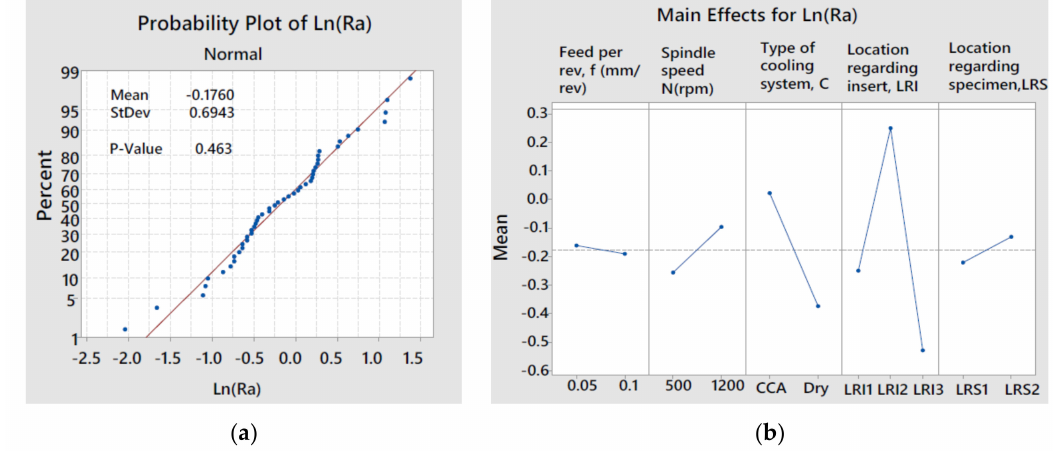
Figure 4. Mg-Al-Mg test. ( a ) Normality of the distribution Ln Ra . ( b ) Main e ff ects over Ln Ra .